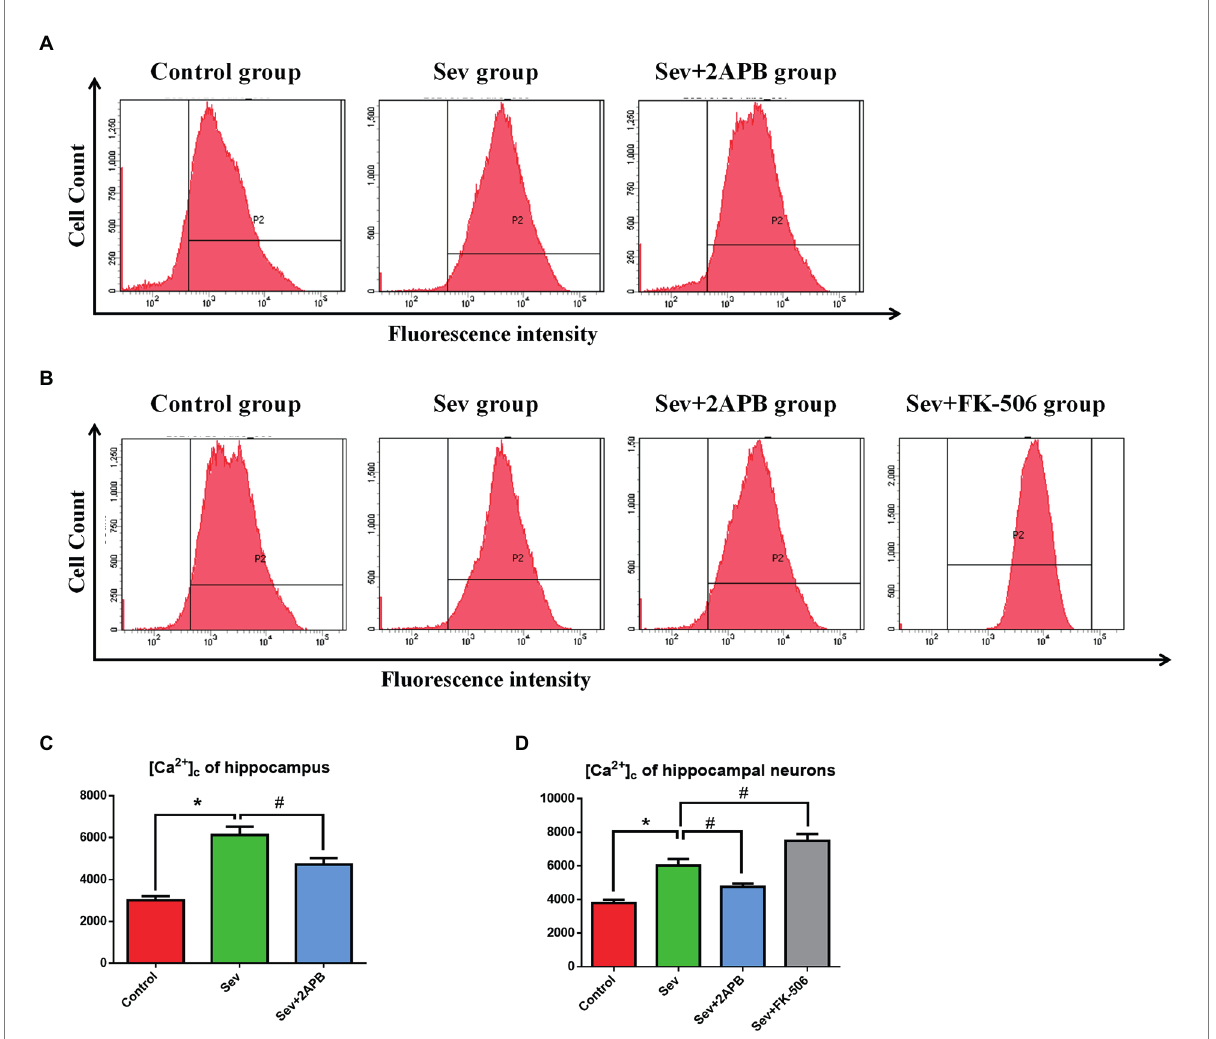
FIGURE 7 Sevoflurane elevates [Ca 2+ ] c in aged rats and isolated hippocampal neurons. (A) Intracellular [Ca 2+ ] c in hippocampal cells of aged rats. (B) Intracellular [Ca 2+ ] c in isolated hippocampal neurons. (C) Representative histograms of [Ca 2+ ] c by flow cytometry in the hippocampus of aged rats. (D) Representative histograms of [Ca 2+ ] c by flow cytometry of isolated hippocampal neurons. Data are presented as mean ± SD ( n = 5 in each group). Compared with the Control group, * p < 0.05; compared with the Sev group, # p <